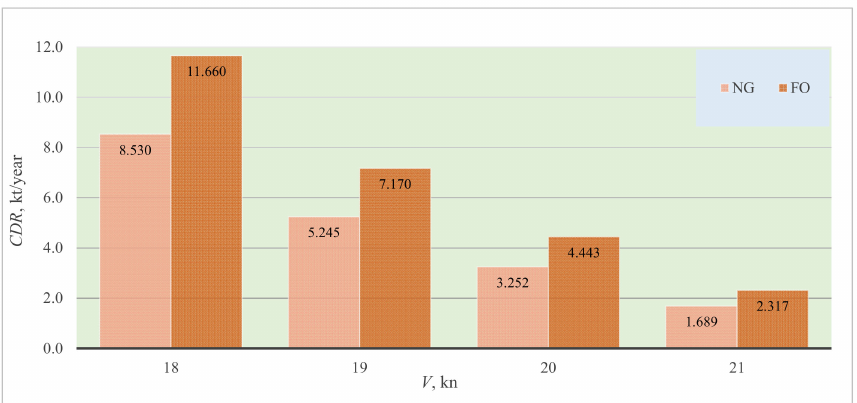
Figure 28. The CO 2 emission reduction per one trip for FO- and NG-fueled mode under